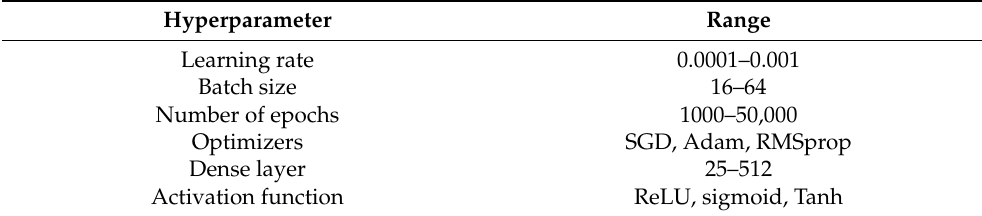
Table 2. Table with the range of hyperparameters for the generative learning models.